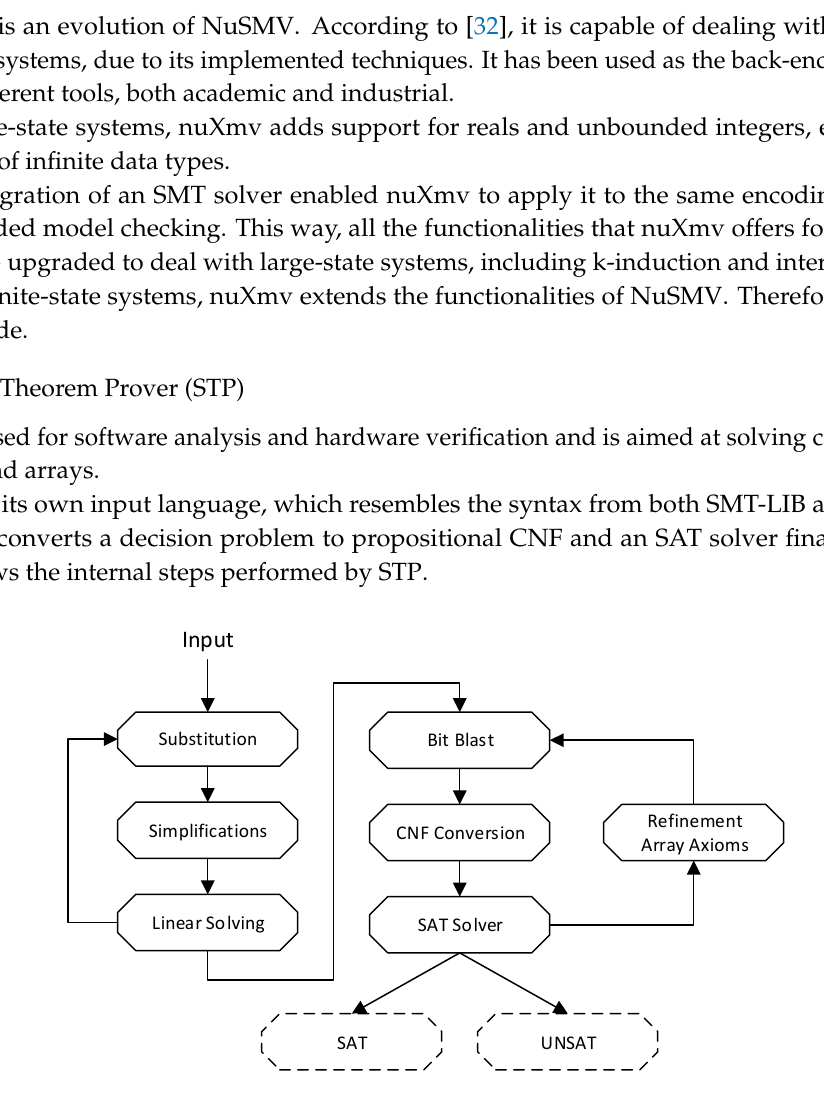
Figure 8. Internal architecture from STP